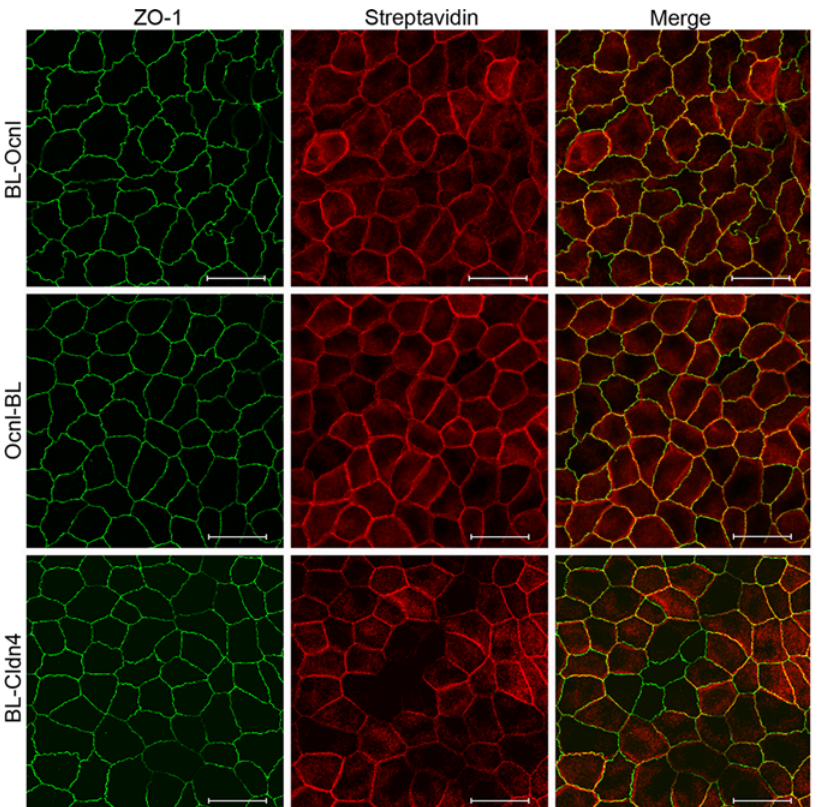
Fig 2. Streptavidin staining of biotinylated proteins reveals proteins at the TJ and lateral membranes. Biotin was added over night to MDCKII cells expressing the various biotin ligase fusion proteins. After wash, fixation, and block fluorescent streptavidin and ZO-1 primary antibody was added. Both biotin ligase fused to the N-terminus (BL-Ocln, myc) and C-terminus (Ocln-BL, myc) of Ocln tagged proteins near ZO-1 (Merge, top right and middle right panel). Biotin ligase fused to the N-terminus of Cldn4 (BL-Cldn4) also partly tags proteins co-localized with ZO-1 but possibly to a lesser extent than Ocln ( Merge , bottom right panel ). Although the majority of streptavidin stained proteins are distributed along the lateral plasma membrane at cell-cell contacts, there are also cytoplasmic staining (middle panel). Streptavidin staining of cells expressing biotin ligase alone reveal a much more diffusely distributed protein staining throughout all compartments of the cell [10]. Bar, 20 microns.